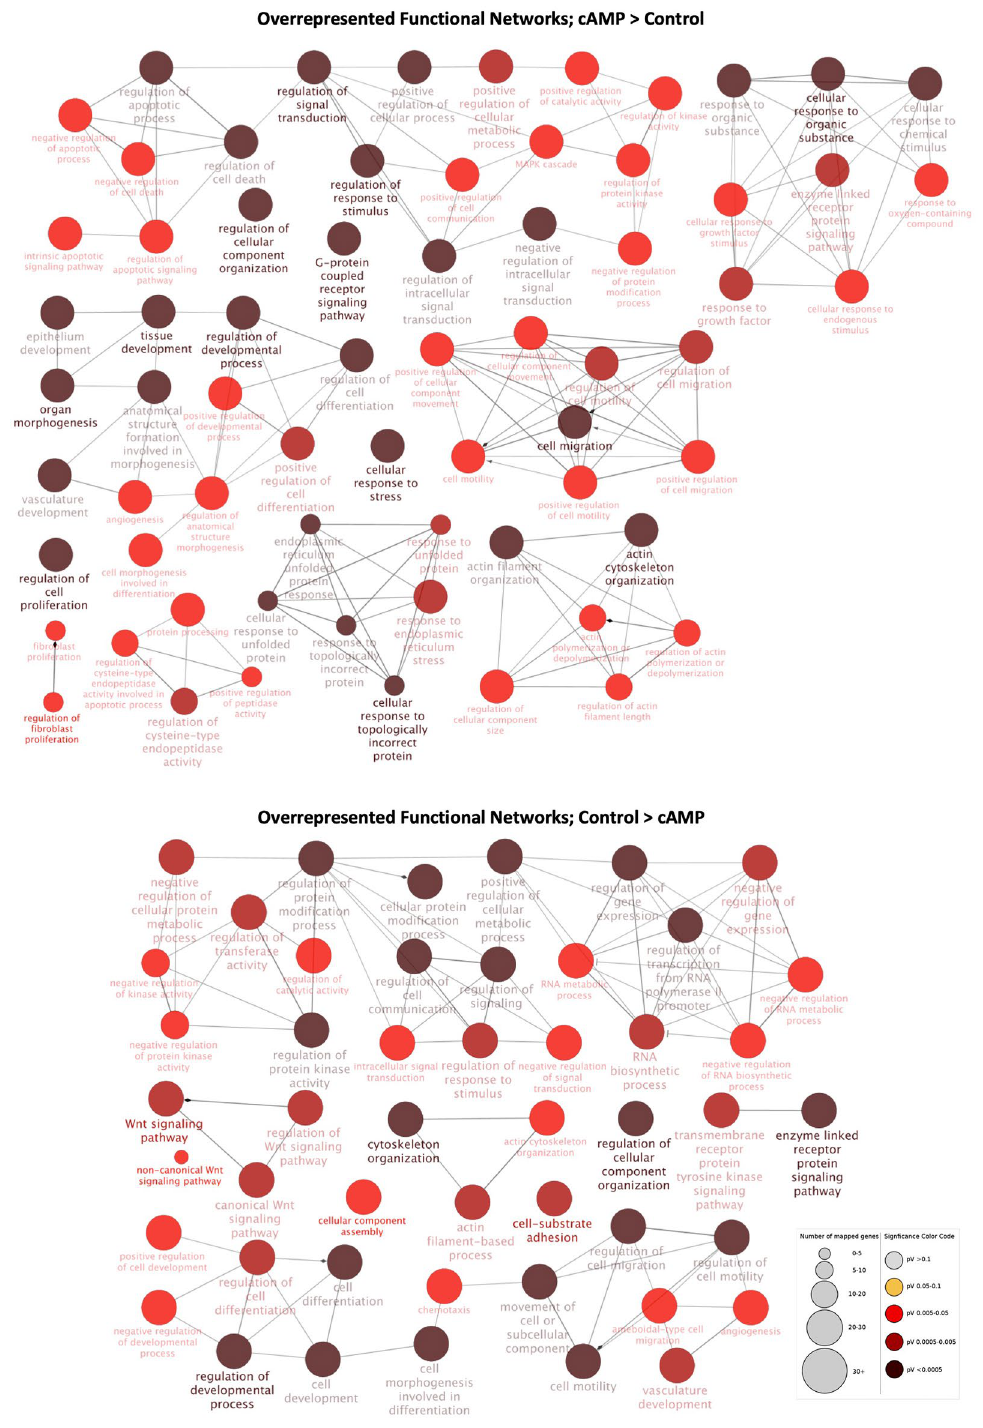
Figure 3. Functional networks overrepresented in the contrast “cAMP versus control”, as determined by ClueGO (Cytoscape). Redundant and non-informative terms were removed, and the resulting networks were manually rearranged. The number of mapped genes for each term is represented by the node size, whereas the level of enhancement is denoted by node color (presented in figure legend). The more highly represented functional networks for both up- and downregulated DEGs after decidualization (upper diagram) were associated with cellular migration, differentiation and cytoskeleton reorganization, angiogenesis, and regulation of kinase activity. Furthermore, networks overrepresented solely for upregulated DEGs (upper diagram) were related to cellular differentiation, response to growth factor and regulation of cell cycle and death, whereas DEGs downregulated after decidualization (lower diagram) were also associated with regulation of protein modification, gene transcription and Wnt